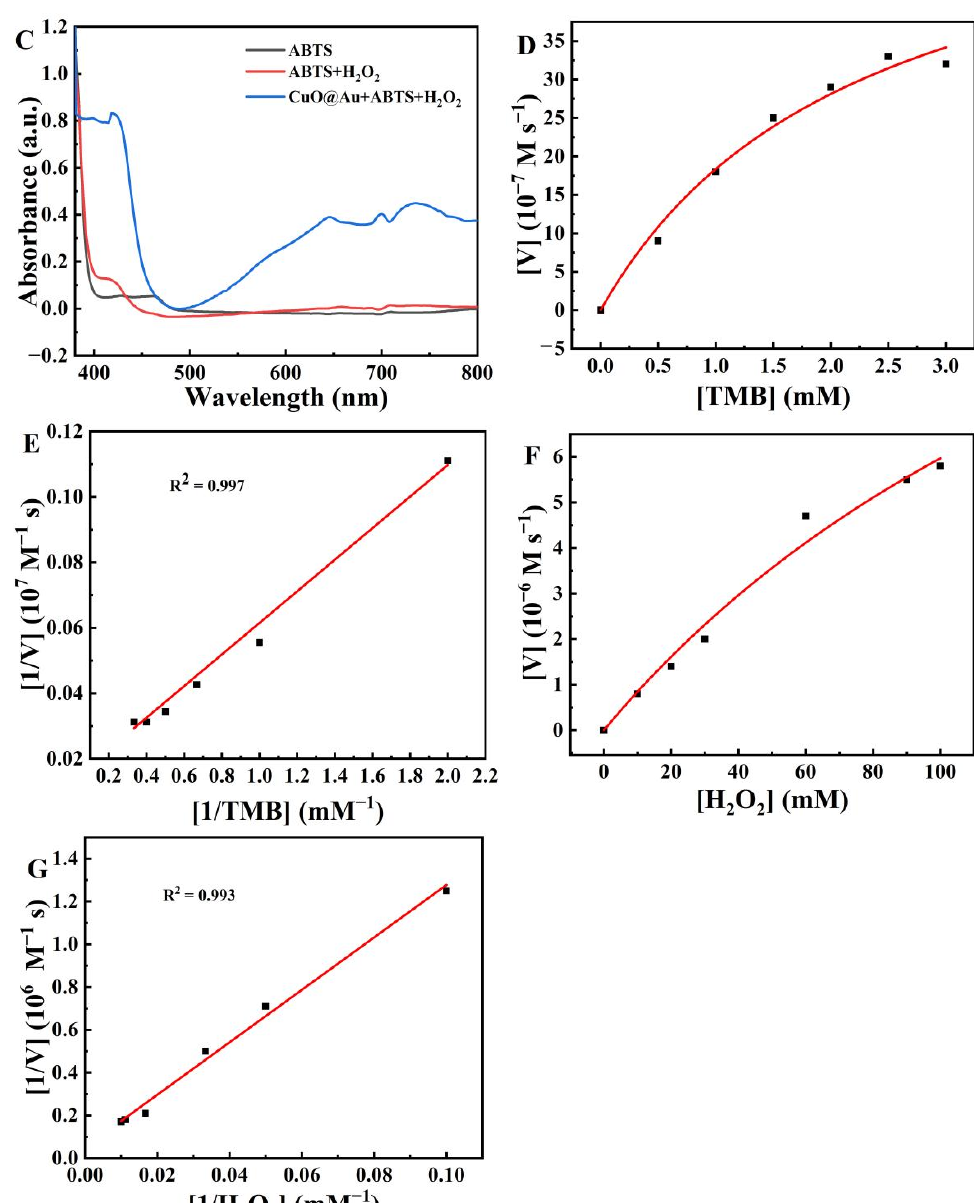
Figure 2. UV-Vis spectra for the oxidation of different substrates by the CuO@Au nanozyme in the presence of H 2 O 2 ( A ) with TMB as substrate at a fixed H 2 O 2 concentration; ( B ) with OPD as substrate at a fixed H 2 O 2 concentration; ( C ) with ABTS as substrate at a fixed H 2 O 2 concentration; ( D ) Michaelis–Menten curve for TMB oxidation by CuO@Au NPs in the presence of H 2 O 2 at different TMB concentrations; ( E ) Corresponding Lineweaver–Burk plot for data in ( D ); ( F ) Michaelis–Menten curve for TMB oxidation by CuO@Au NPs in the presence of TMB at different H 2 O 2 concentrations; ( G ) Corresponding Lineweaver–Burk plot for the data in ( F ).